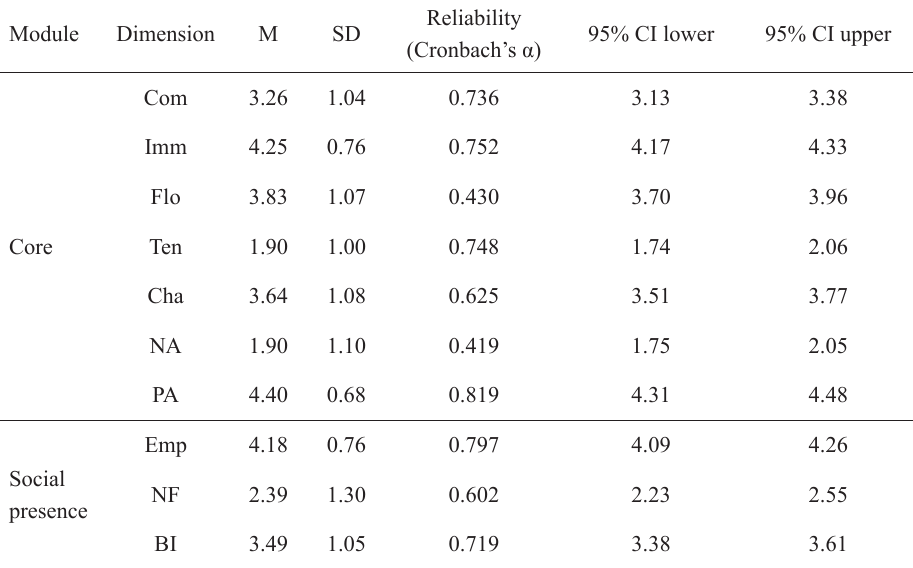
Table 6. Reliability for the dimensions of the GEQ (Scale range from 1 to 5 : 1 = strongly disagree, 5 = strongly